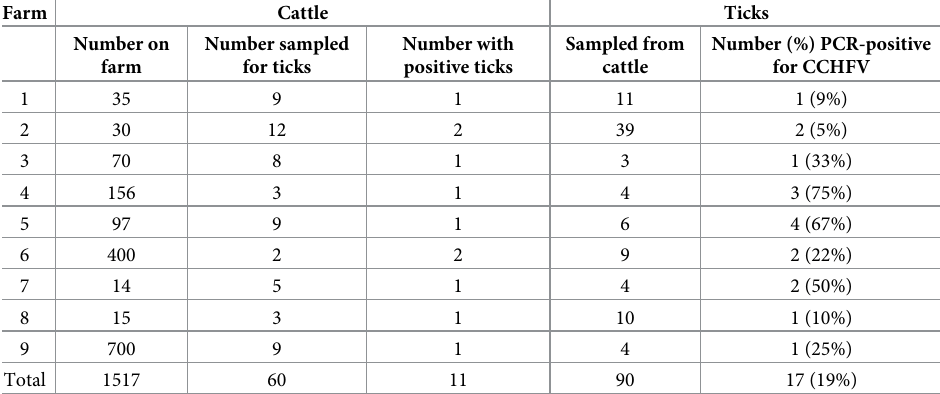
Table 5. Crimean-Congo haemorrhagic fever virus RNA detection in Hyalomma spp. ticks on farms where posi- tive ticks were found in central South Africa,